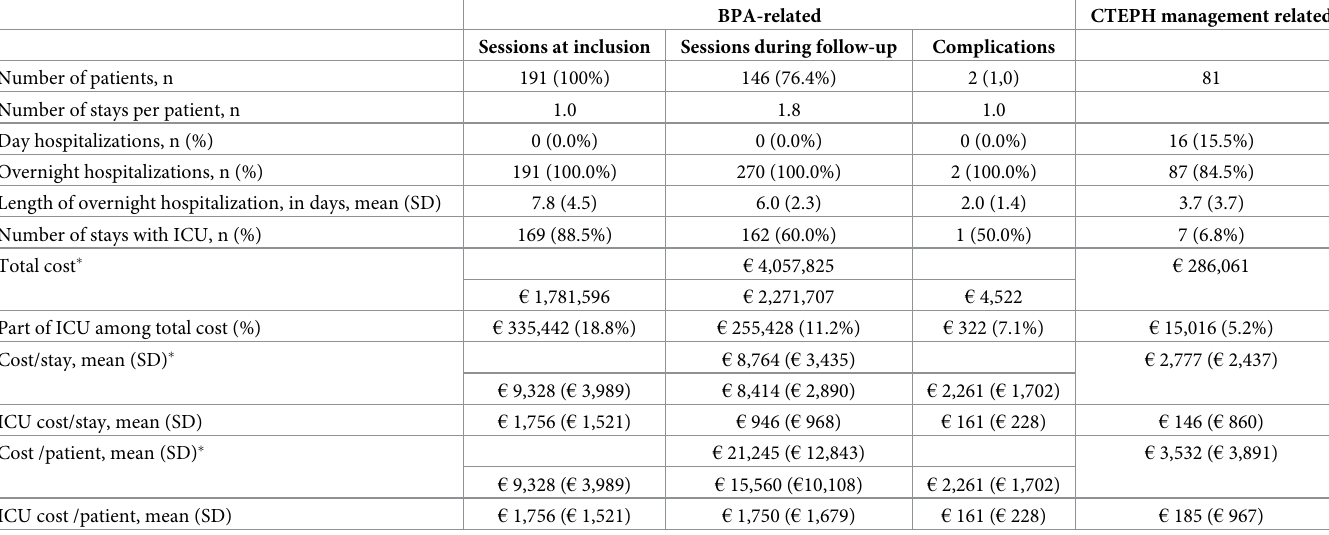
Table 2. Healthcare resource use and cost of hospital stays.